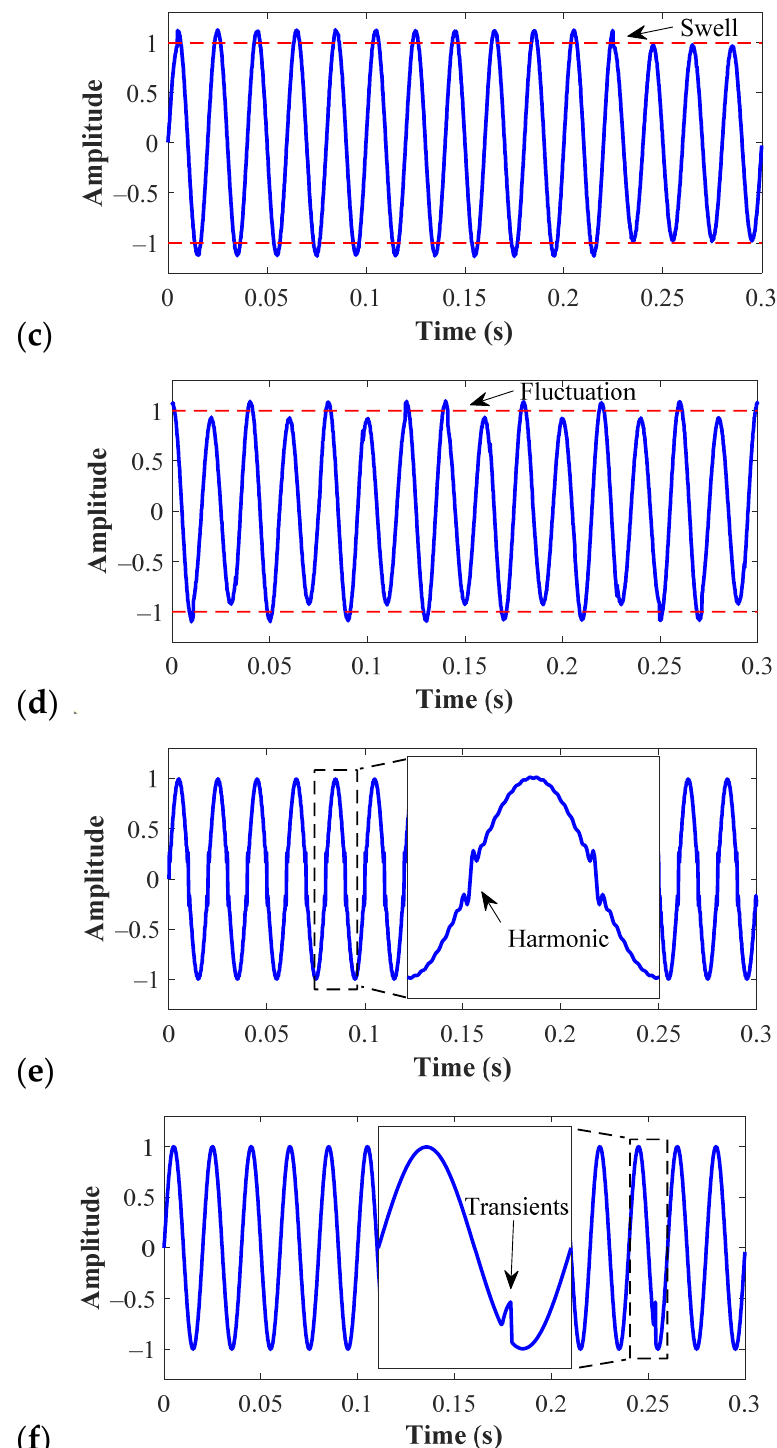
Figure 5. Set of different electrical signals that are synthetically generated and that belong to evaluated conditions: ( a ) healthy or normal, ( b ) sag voltage, ( c ) swell voltage, ( d ) voltage fluctuations, ( e ) harmonic distortion and ( f ) transients.